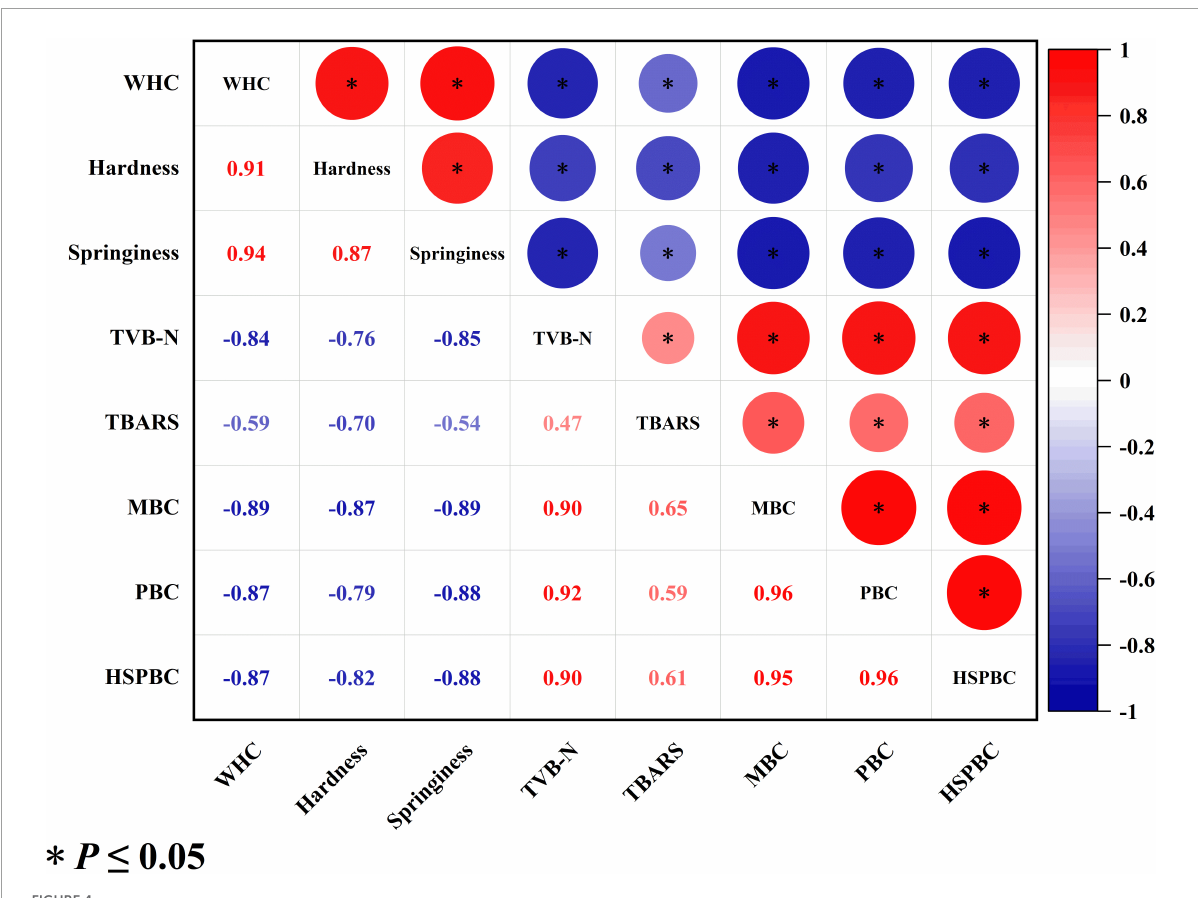
FIGURE4 Correlation analysis of the quality indicators of salmon filets during cold chain